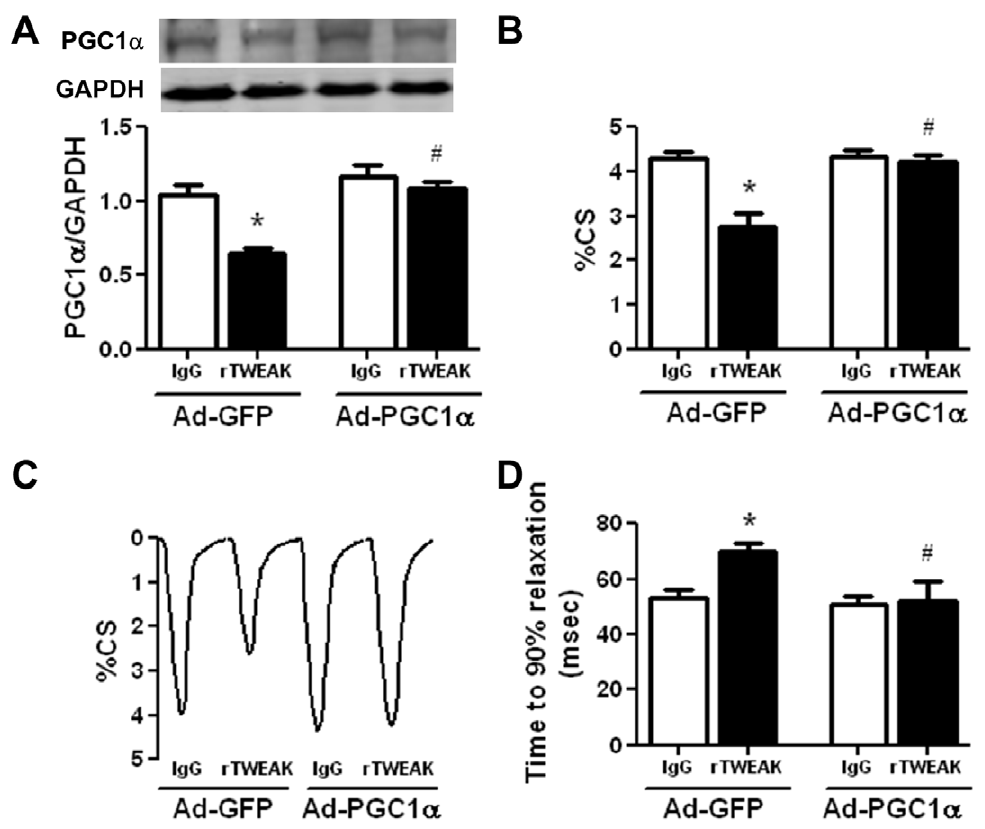
Figure 5. Maintenance of PGC1 a levels protects against TWEAK-induced contractile dysfunction in isolated cardiomyocytes. Isolated cardiomyocytes were infected with adenovirus (MOI of 10) expressing GFP or PGC1 a for 24 hours prior to treatment with IgG or rTWEAK for 48 hours. (A) Western blot analysis of PGC1 a expression, normalized with GAPDH. N=3 independent biological replicates group. (B) Isolated cardiomyocyte function (%CS) was determined using edge detection method. (C) Representative tracings of single cell shortening at indicated conditions. (D) Time to 90% relaxation in isolated cardiomyocytes. Cellular function was assessed in three independent biological replicates and data from 8–12 cells was averaged as N=1 for a given experiment. * p , 0.05 vs. IgG and # p , 0.05 vs. rTWEAK in Ad-GFP group.